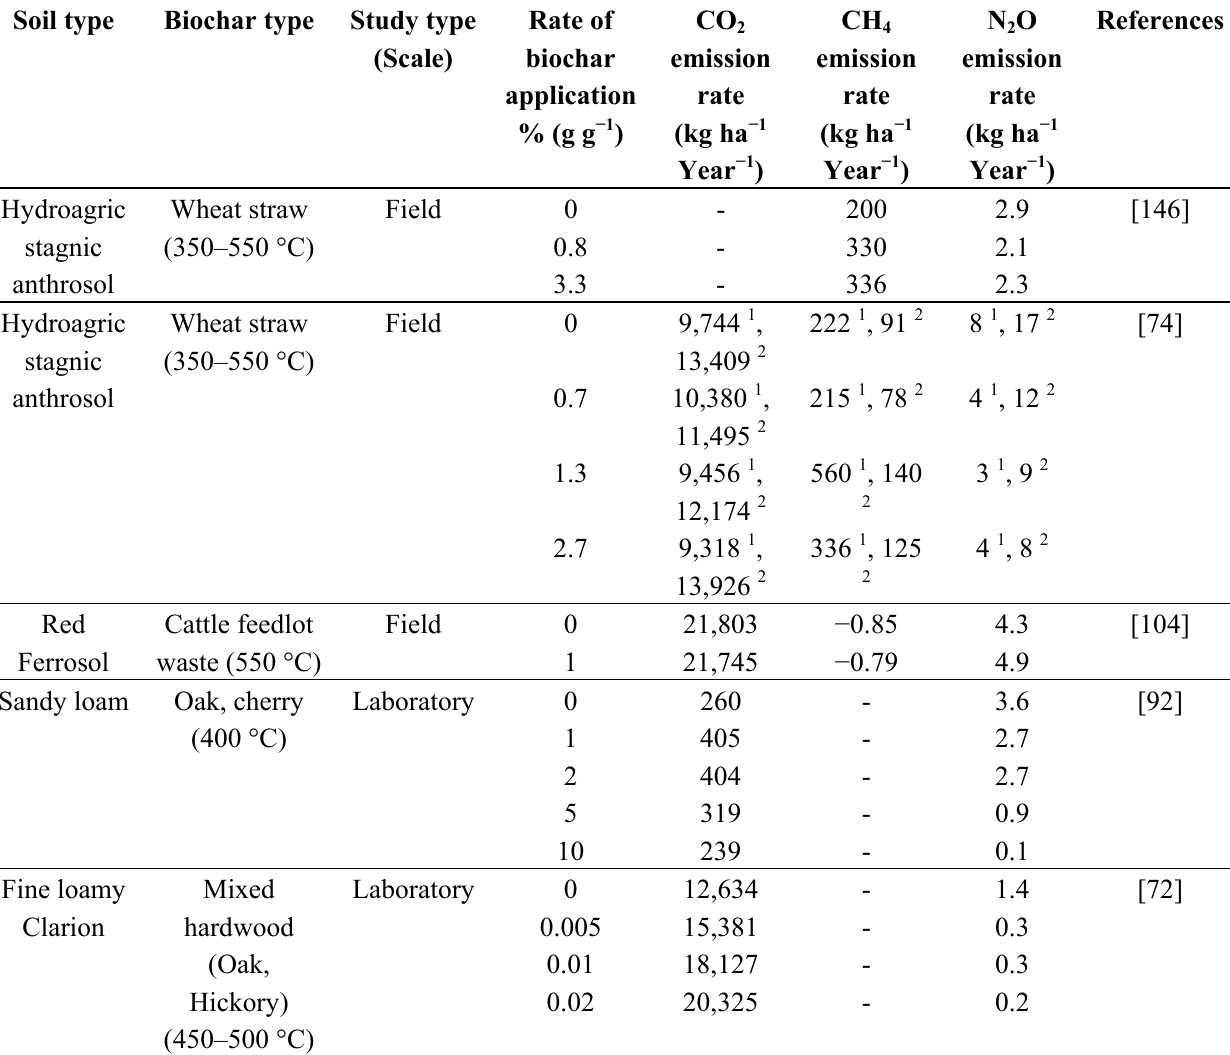
Table 5. Impact of biochar on greenhouse gas (GHG) emission